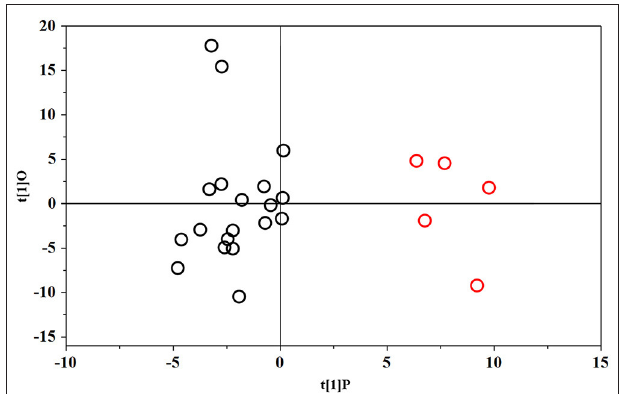
FIGURE 2 | OPLS-DA scores plot of 1 H NMR spectra of urine samples: ≤ 30w No-hsPDA (black circle) and ≤ 30w hsPDA (red